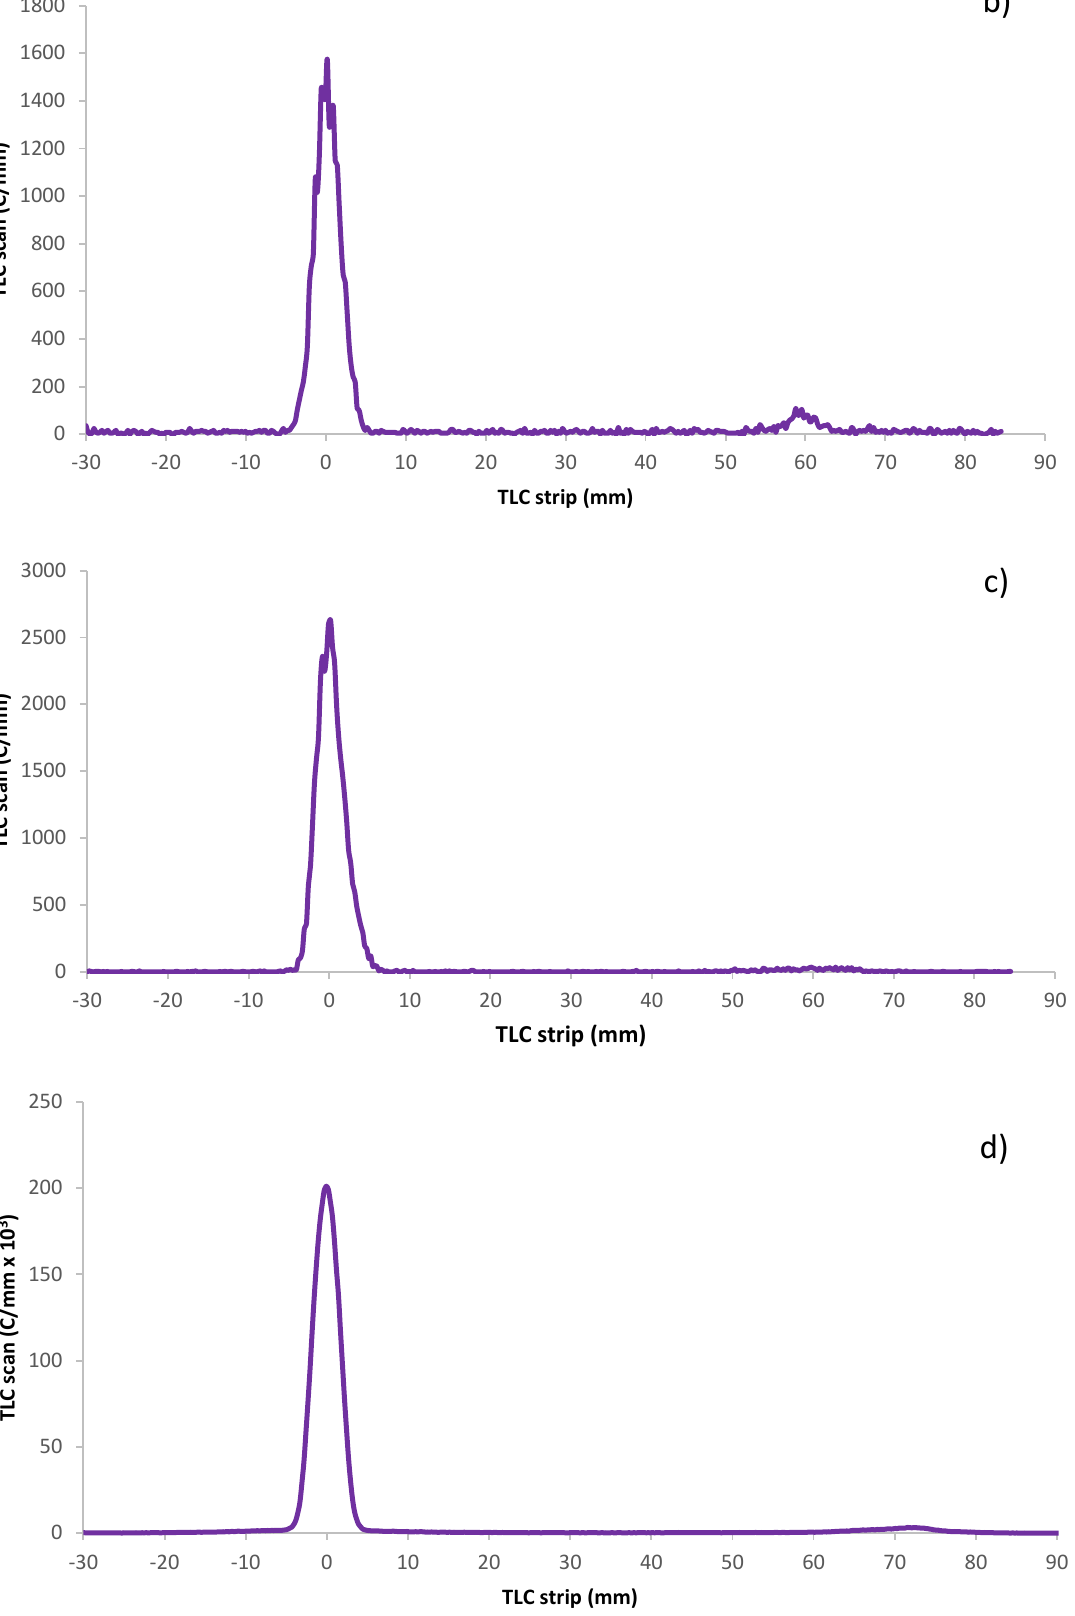
Figure 7. Radioactive peaks on radio thin layer chromatography (TLC) scanner of ( a ) free 211 At, large polymer ( b ) 22.5 kDa, ( c ) 21 kDa, and ( d ) small